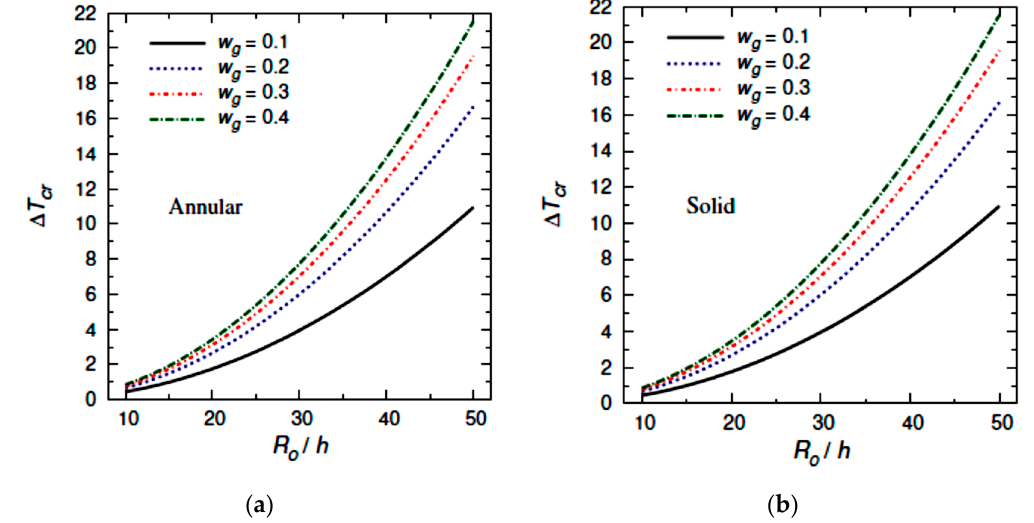
Figure 3. Effects of the outer radius to thickness ratio R o / h and graphene weight fraction w g on the critical buckling temperature ∆ T cr of simply supported SGP ( a ) annular and ( b ) solid circular plates ( R i / R o = 0.7, κ = 2, E ζ = 0.05 V/m, µ = γ = 2 nm, ∆ C = 0.5%, e 0 = 3 × 10 5 , J 1 = 100, J 2 = 10).